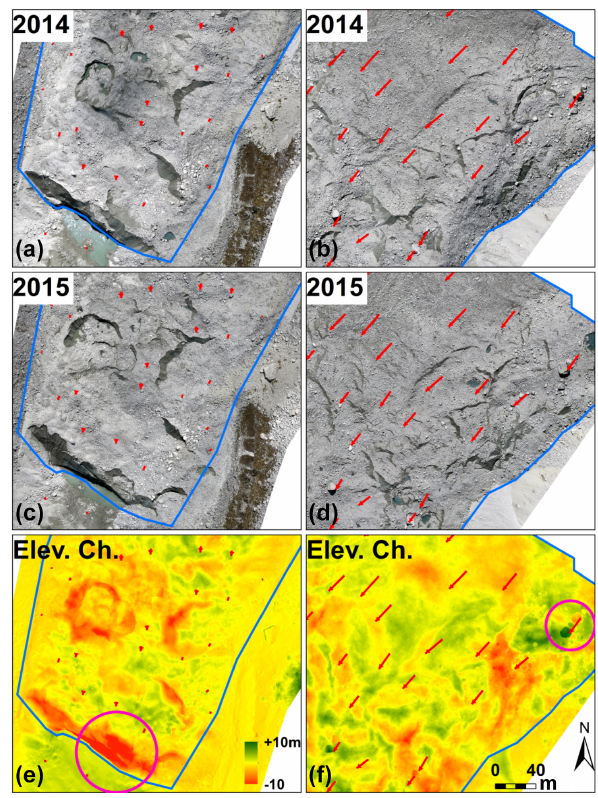
Figure 9. Locations of maximum and minimum change in ice ele- vation on Llaca Glacier tongue. Panels (a) and (b) show 2014 or- thomosaic; panels (c) and (d) show 2015 orthomosaic; and pan- els (e) and (f) show elevation change where 2014 elevation is sub- tracted from 2015 elevation (i.e. negative value is ice loss). Maxi- mum ice loss of 18m occurred at the calving face (pink circle lower left panel). Maximum gain of 11m is recorded in upper right sec- tion where a large boulder (roughly 10m tall) has moved through the scene (visible by comparison of 2014 and 2015 orthomosaics). Blue line is glacier tongue boundary; red arrows are velocity mea- surements. Note: elevation change values are truncated to ± 10m for display purposes. Location of panels is depicted in Fig. 7 inset boxes: 3 – left panels; 1 – right